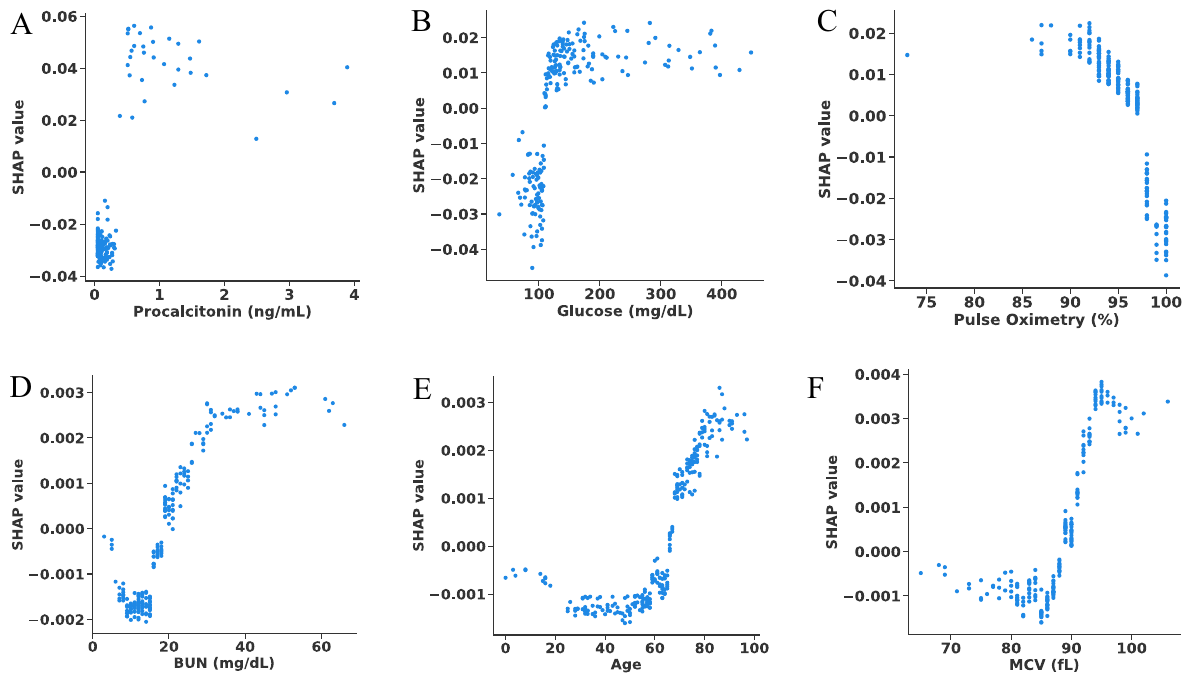
Figure 6. SHAP scatter plot for prediction using all features for the best performing fold. Positive SHAP values imply the corresponding feature was indicative of ventilation/death. Negative SHAP values imply the corresponding feature was indicative of no ventilation/discharged. A zero SHAP value implies the feature has no impact on the predicted outcome. The normalized range of value of features are color-coded.